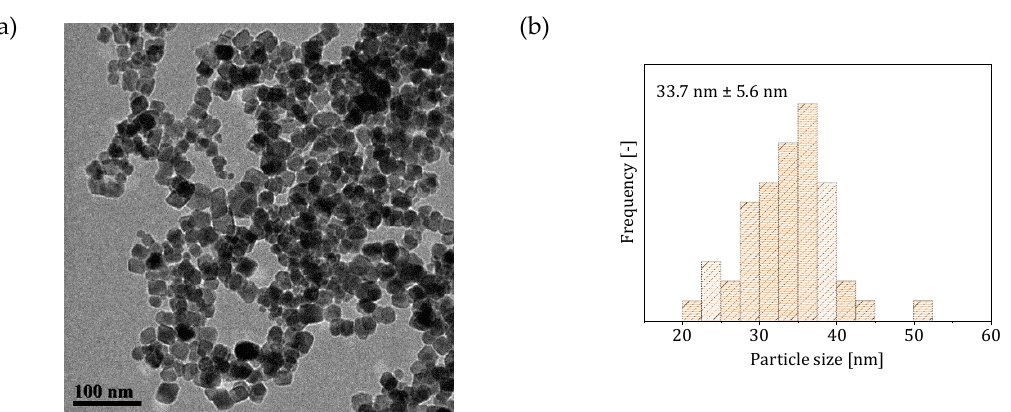
Figure 6. ( a ) TEM micrographs and ( b ) particle size distribution of particles obtained from the large-scale version of Reactor System 3.